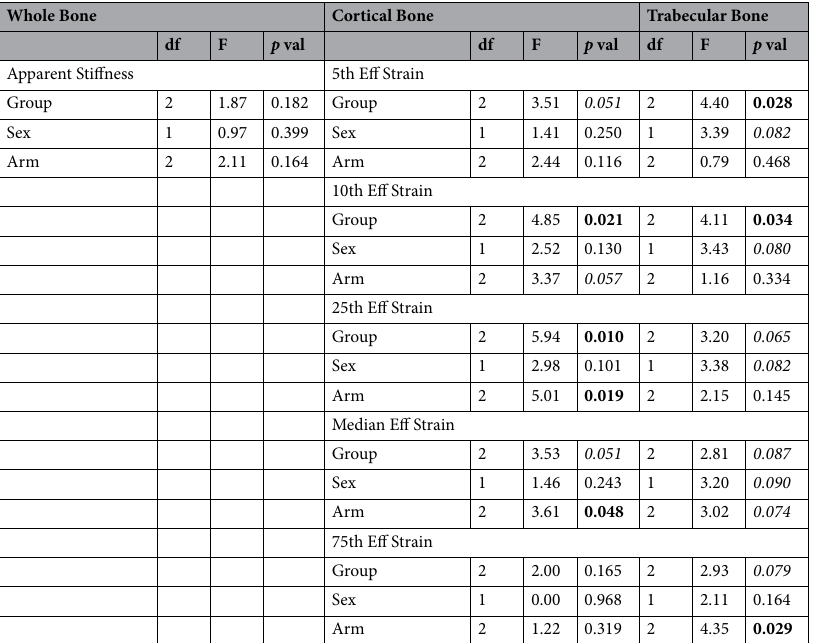
Whole Bone Cortical Bone Trabecular